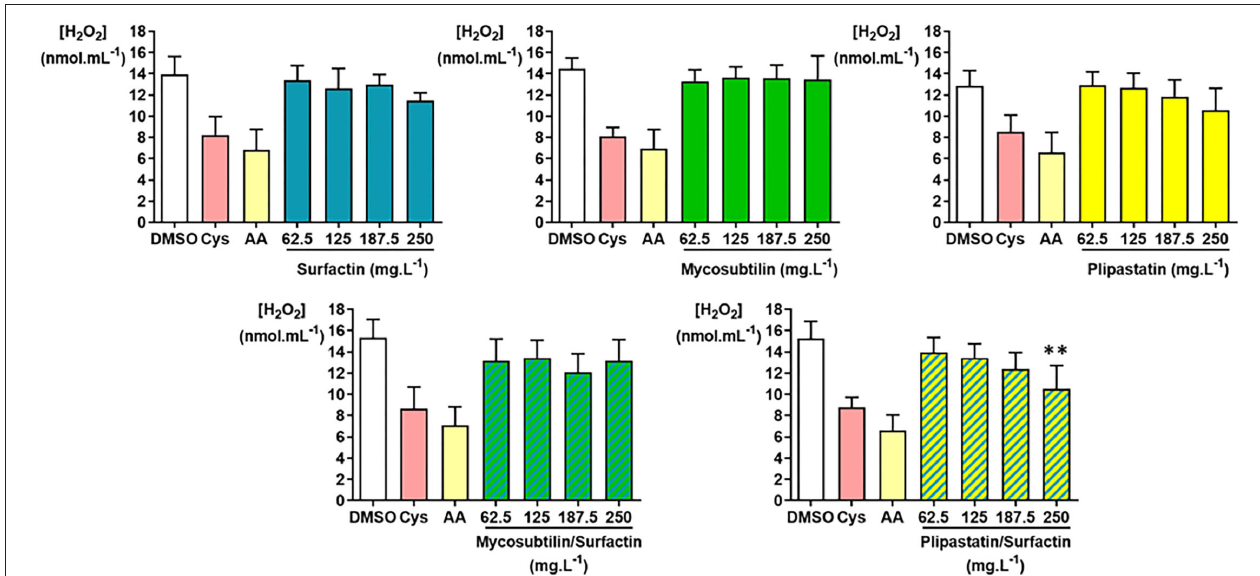
FIGURE 4 | Inhibition of hydrogen peroxide (H 2 O 2 ) by the lipopeptides of interest (surfactin, mycosubtilin, plipastatin, mixture of mycosubtilin/surfactin, and mixture of plipastatin/surfactin) in a cell-free model. The effects on H 2 O 2 of lipopeptides tested at concentrations between 62.5 and 250mg.L − 1 (for the mixture, the concentrations indicated correspond to the concentration of each of the two lipopeptides) were compared to those of the DMSO-negative control. The positive controls for H 2 O 2 inhibition were cysteine (Cys) and ascorbic acid (AA) tested at concentrations 0.3 mmol.L − 1 and 30 µ mol.L − 1 , respectively. Statistical analysis of the data was performed with 6 independent experiments using ANOVA (overall Fisher’s test at the p = 0.05 level and Tukey’s multiple a posteriori comparison test) for surfactin, mycosubtilin, plipastatin, and mycosubtilin/surfactin and using the Kruskal-Wallis test (Dunn’s multiple a posteriori comparison test) for plipastatin/surfactin, with the GraphPad Prism software, ** p < 0.01). Results are presented as a bar graph (means ±